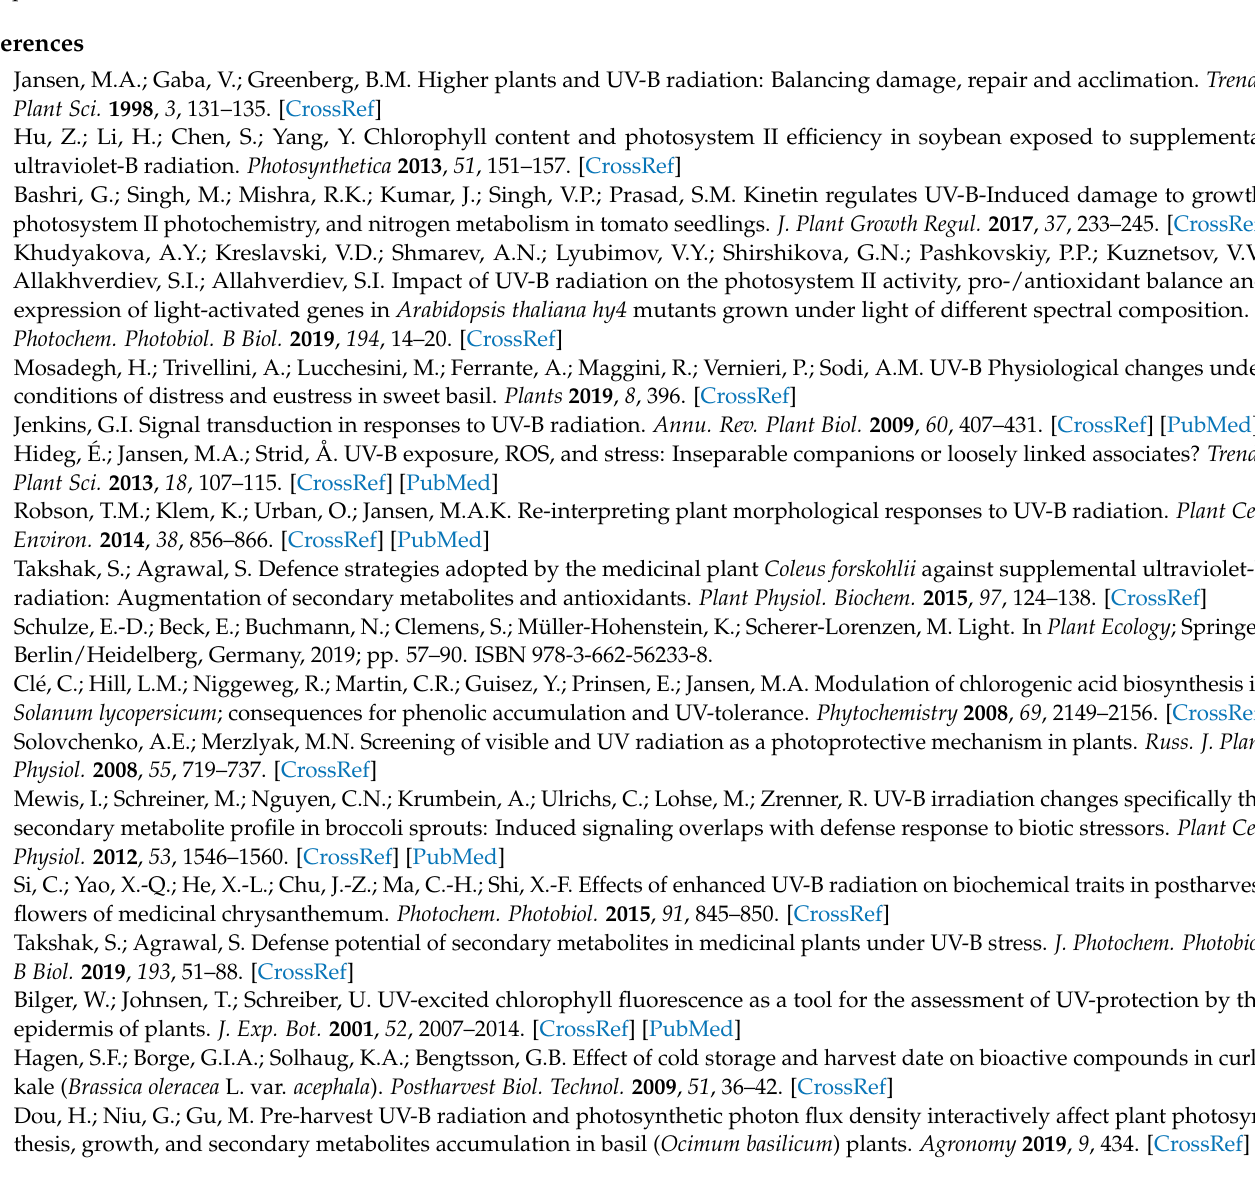
Figure A2. Representative kinetic chlorophyll fluorescence curves ( a ). ML, measuring light (a short flash of very weak intensity, 5 s duration, <0.5 μmol m −2 s −1 ); AL, actinic light; and SP, saturating pulses (800 ms duration, 1200 μmol m −2 s −1 ). ( b ) The chlorophyll fluorescence parameter images according to the leaf order: F v / F m , the maximum quantum yield of PSII (Equation (1)). The leaf order indicates the order from the oldest leaf at the bottom to the youngest leaf at the top in a whole plant.